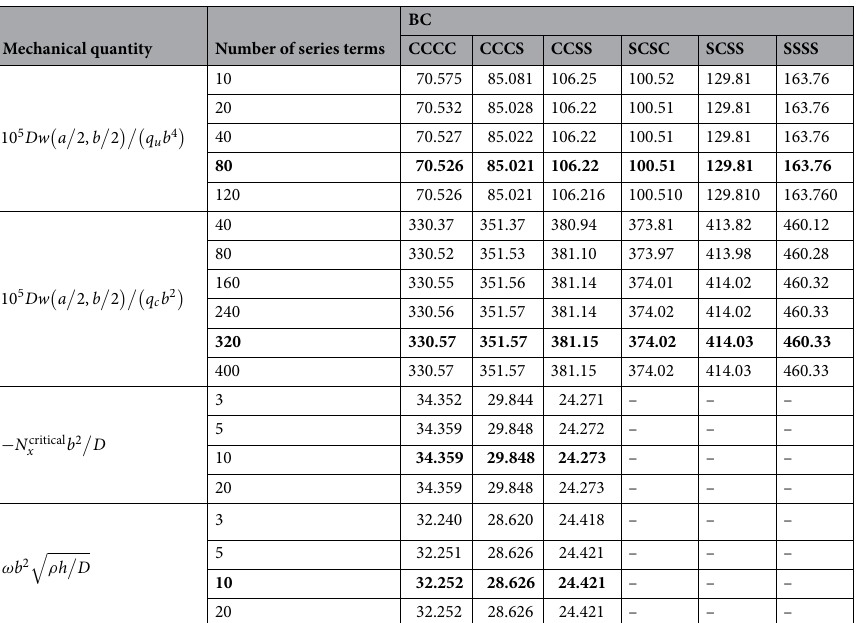
Table 1. Convergence study for bending, buckling, and free vibration solutions of the square nanoplates with 2 b = 10 nm, µ = 1 nm , and k p = 20 under different BCs.